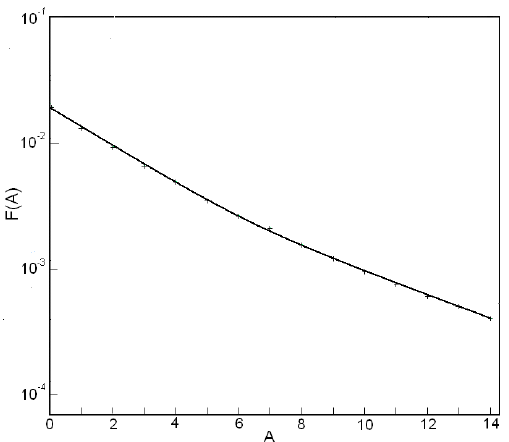
Figure 3. Dependence of the factor F(A) in Eq. (1) on the anisotropy index A of the proton fluxes.